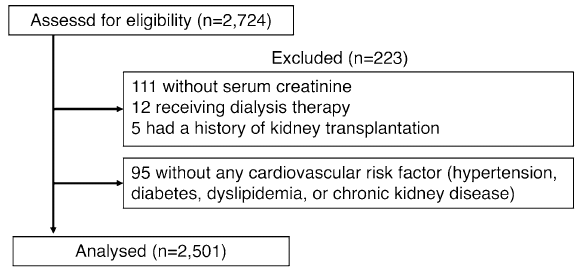
Figure 1. A flowchart representing the participants’ inclusion into the present